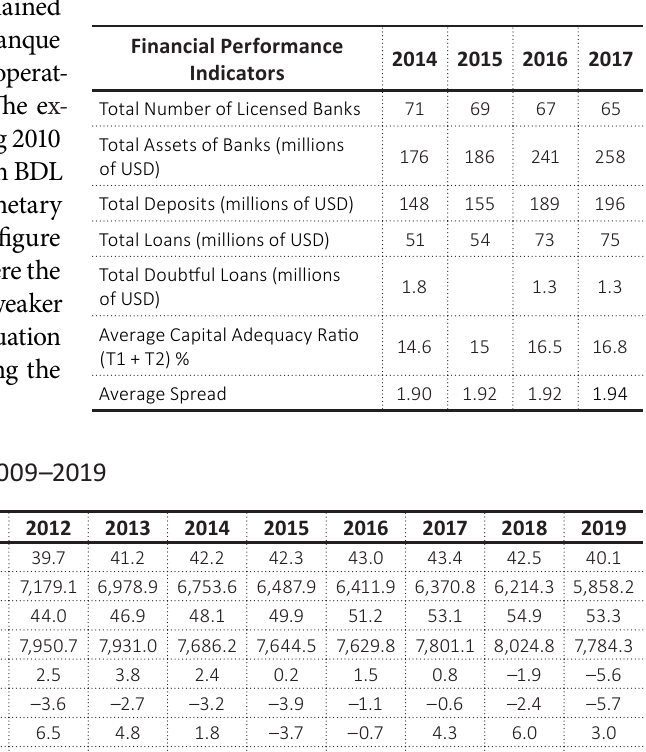
Table 2. Overview of financial performance